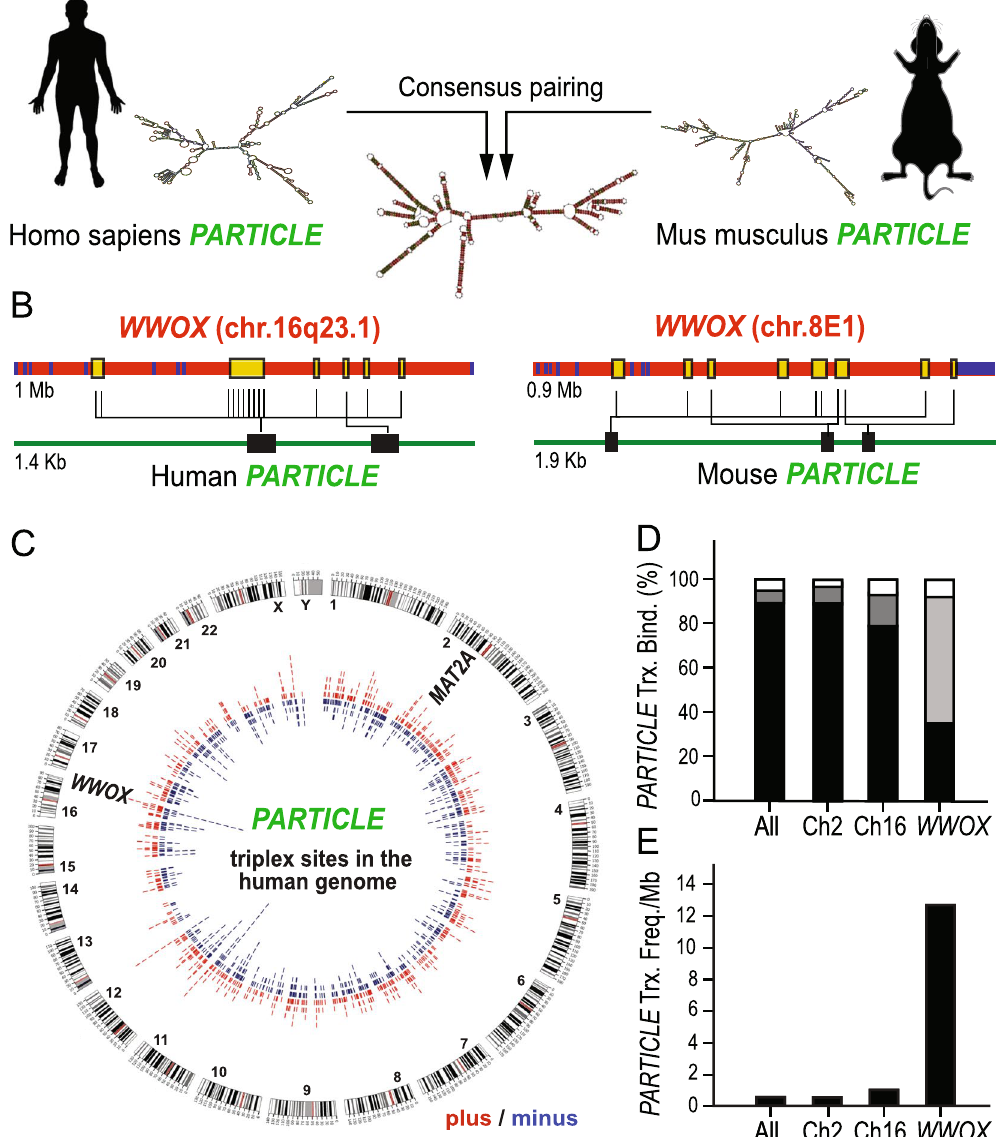
Figure 1. Predicted PARTICLE consensus structure and triplex formation with one local enrichment at the WWOX tumor suppressor locus on chromosome 16. ( A ) Secondary structure minimum free energy (MFE) prediction of PARTICLE in human (left) and mouse (right) with LocARNA consensus pairing (centre; compatible base pairs are colored). ( B ) Schematics of the WWOX locus on human chromosome 16 and mouse chromosome 8 (upper, exons in blue boxes) and predicted triplex binding sites (yellow boxes) with PARTICLE (vertical lines, lower). ( C ) GENCODE hg19 assembly with PARTICLE triplex sites on plus (red) and minus (blue) genomic strands as identified by Triplexator v1.3.2. The genomic location of tumor suppressors MAT2A and WWOX are indicated. ( D ) Percentage of triplex binding sites (involving PARTICLE regions 1098–1114 nucleotides (white), 629–646 nucleotides (grey) and 624–644 nucleotides (black)) and ( E ) PARTICLE triplex frequency per megabase on all human chromosomes combined (All), chromosome 2 (Ch2) and 16 (Ch16) and within the WWOX locus. Human silhouette (id:47607240,